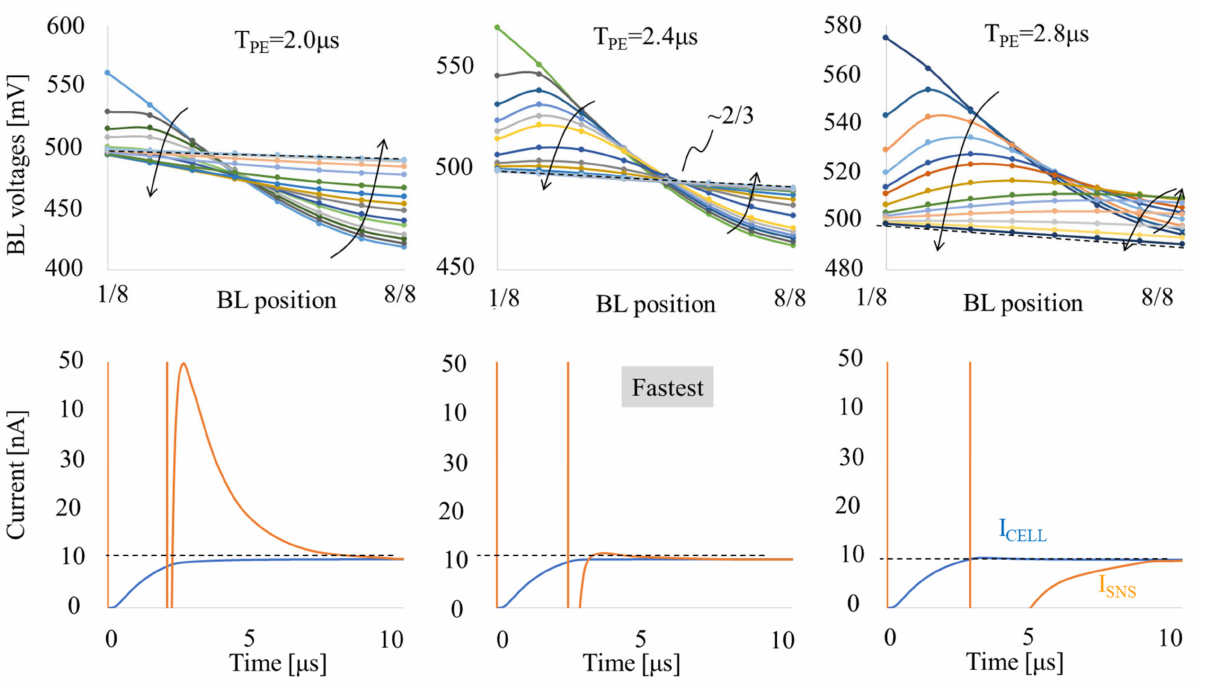
Figure 8. BL voltage ( upper ) and current waveform ( lower ) with different Tpre (2.0 µ s, 2.4 µ s and 2.8 µ s from left to right, respectively) values when the “0” cell at x = 100% is